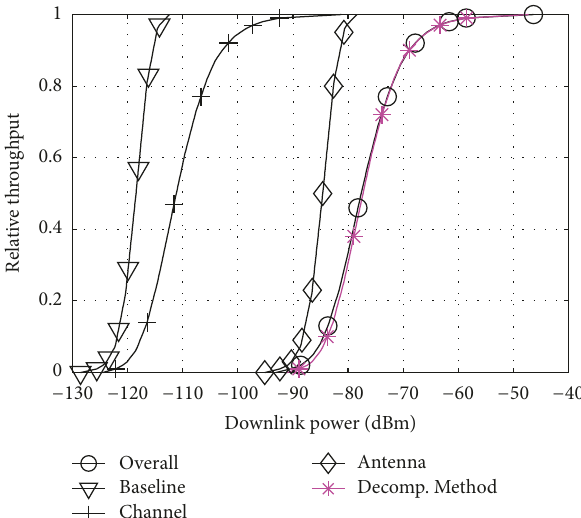
Figure 10: Simulation result example: downlink power versus relative throughput; ICD/ZF receiver, DLSCH processing on, ideal channel estimation, correlation low, and antenna condition number 40